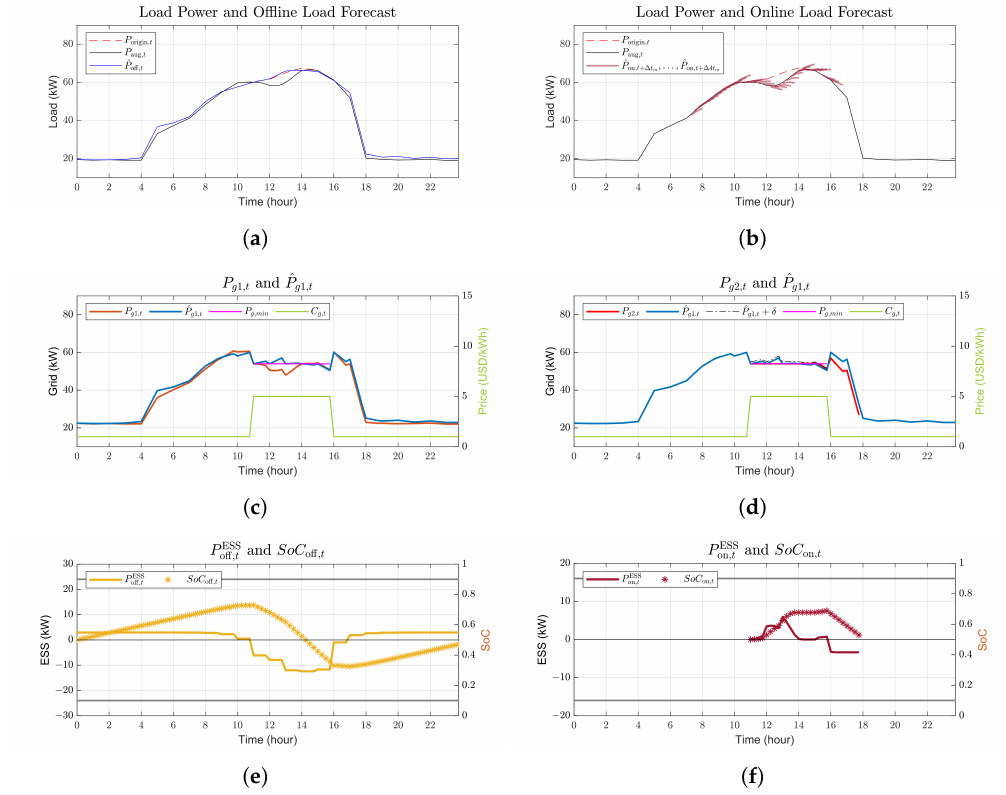
Figure 12. Offline ESS scheduling and online ESS operations with negative synthetic uncertainties. ( a ) Offline load forecast, ( b ) Online load forecast, ( c ) The estimated power ˆ P g 1, t and real power P g 1, t from the main grid by using only ESS off , ( d ) The estimated power ˆ P g 1, t and real power P g 2, t from the main grid by using both ESS off and ESS on , ( e ) The amount of charging or discharging of ESS off